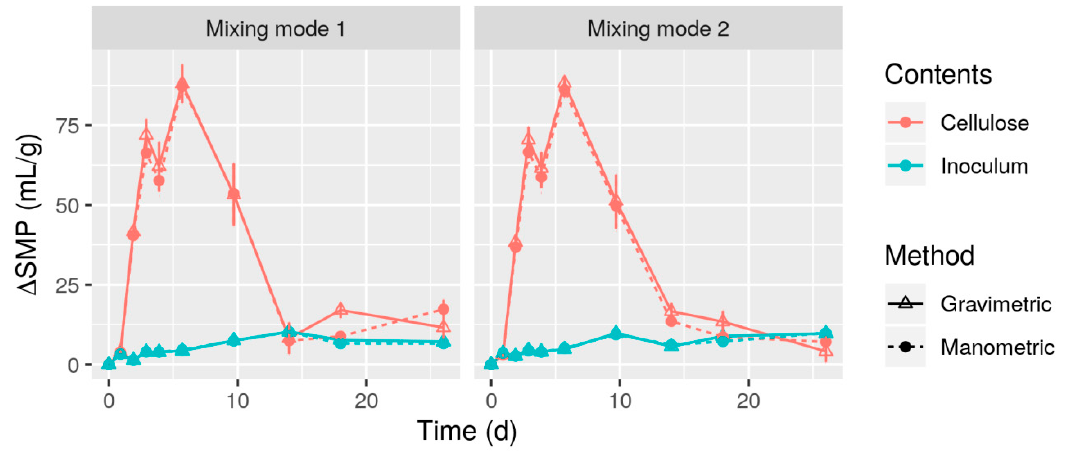
Figure 4. Change in SMP between two consecutive measurement points for BMP tests with mixing mode 1 ( left ) and 2 ( right ). Each point shows an average value ( n = 5) and vertical lines show standard deviation.